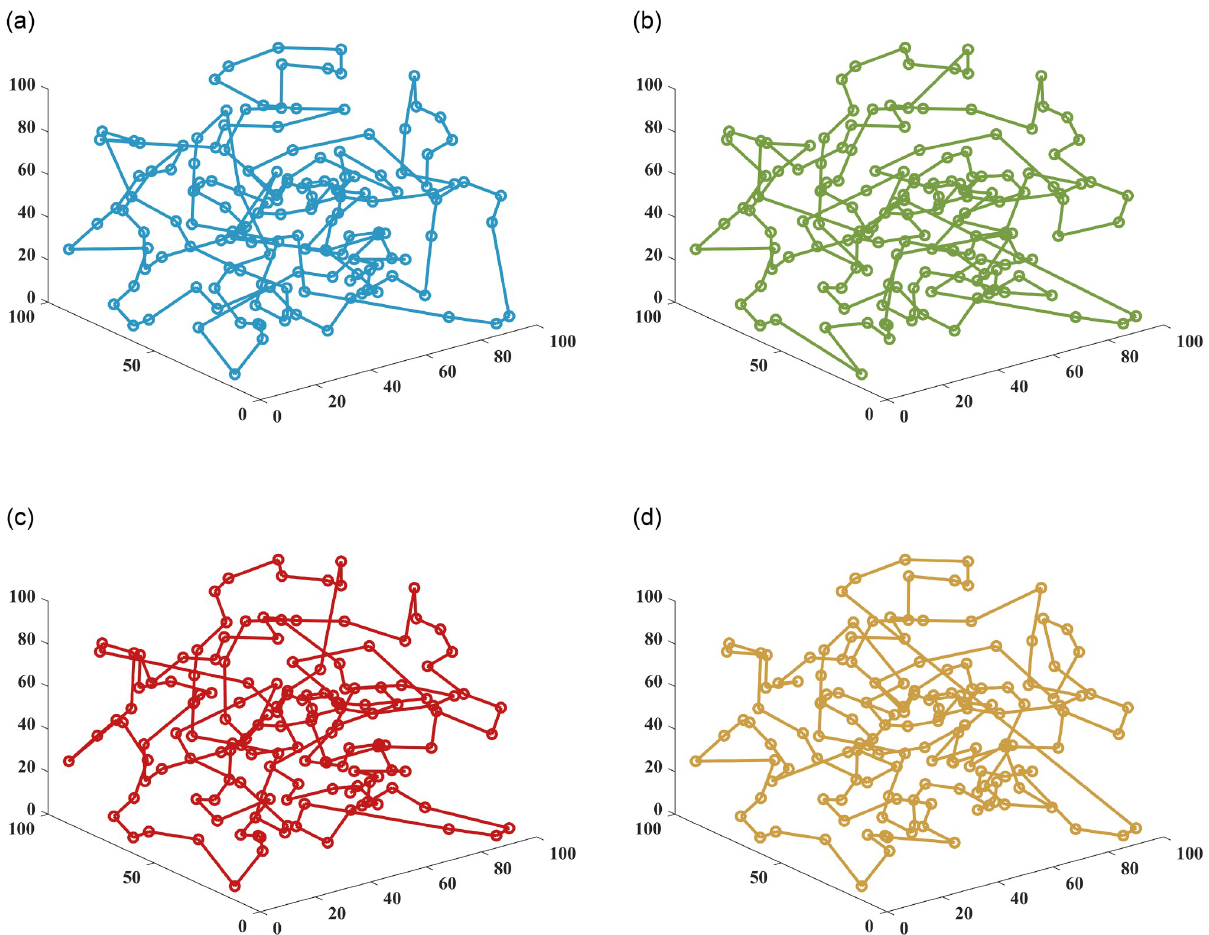
Fig 8. Picked roadmap obtained by four algorithms under 150 fruits. (a) ACO Picking Path. (b) ASrank Picking Path. (c) IACO Picking Path. (d) OSACO Picking